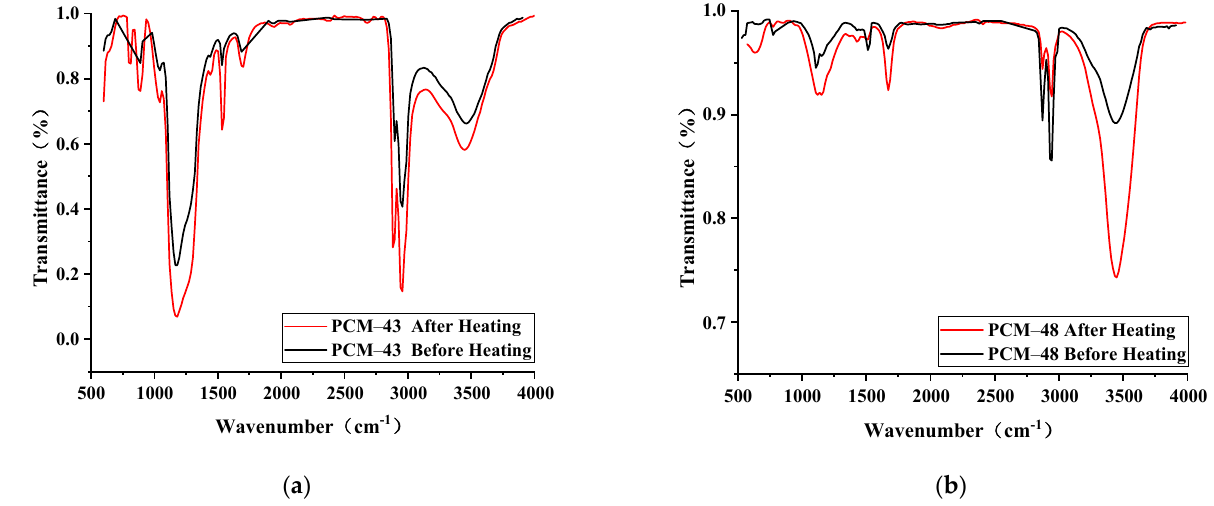
Figure 3. Comparison of transmittance change before and after heating: ( a ) PCM-43; ( b ) PCM-48.